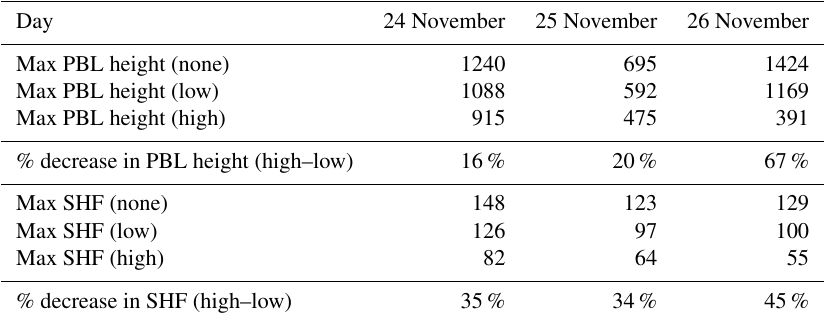
Table 4. Change in maximum PBL height (taken as the height between 12:00 and 16:00LST with a maximum gradient in potential temper- ature) and SHF for all 3d with high and low aerosol